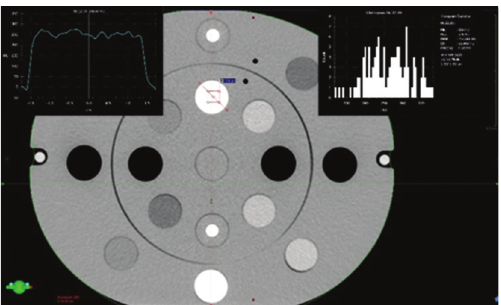
FIGURE 3. Axial Computed tomography scan of computerized imaging reference systems 062M pelvis phantom with region of interest analysis (Histogram and Hounsfield units